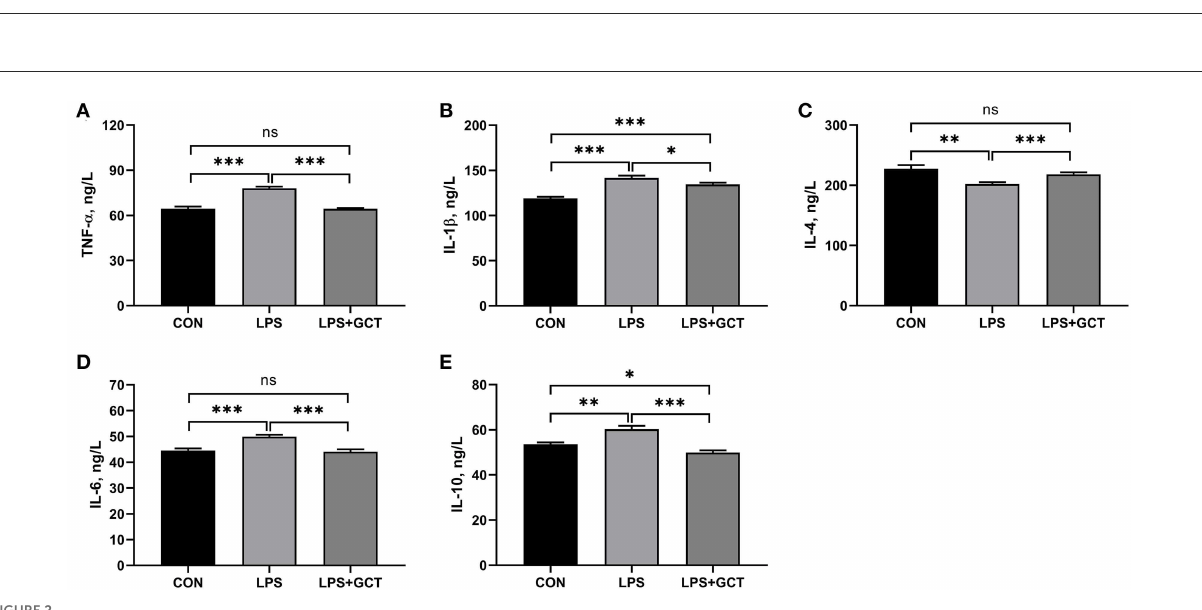
FIGURE2 Effects of dietary Galla Chinensis tannin (GCT) supplementation on serum inflammatory factors of broilers under lipopolysaccharide (LPS)-challenge. (A) Tumor necrosis factor- α (TNF- α ); (B) Interleukin-1 β (IL-1 β ); (C) Interleukin-4 (IL-4); (D) Interleukin-6 (IL-6); (E) Interleukin-10 (IL-10). CON, fed on a basal diet and intraperitoneally injected with saline solution; LPS, fed on a basal diet and intraperitoneally injected with LPS; LPS + GCT, fed on a basal diet supplemented with 300 mg/kg GCT and intraperitoneally injected with LPS. Values are presented as mean ± standard error ( n = 6). * p < 0.05, ** p < 0.01, *** p < 0.001; ns,